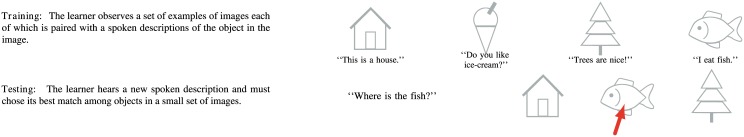
Illustration of the cross-modal classification task that models the recognition of an object from its name, after cross-modal habituation.The learner perceives multimodal signal, vision and sound in the figure, and learns the associations between the appearance of objects and the sound of their names. It then has to prove its ability to chose the right object among a small set when hearing its name. In practice we use images of objects, motion captures, and recorded spoken utterances in the experiments.